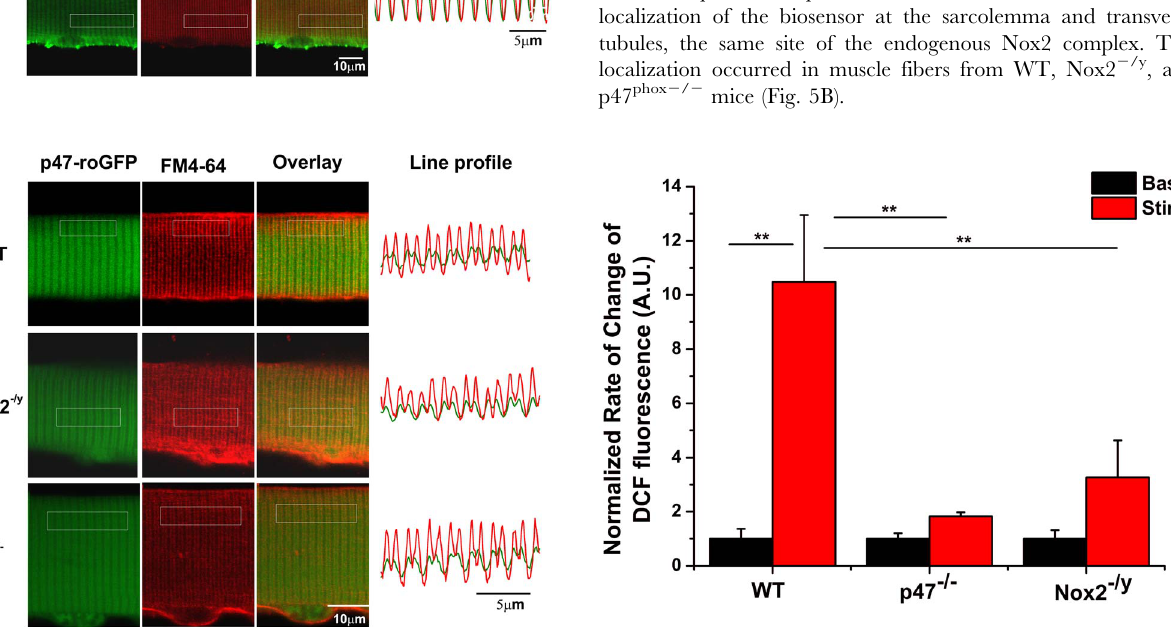
Figure 5. Localization of p47-roGFP in skeletal muscle. (A) Immunostaining of enzymatically dissociated single FDB myofibers for endogenous p47 phox and the ryanodine receptor shows that p47 phox co-localizes with the ryanodine receptor at the triad. (B) Fluorescent live cell image of an FDB electroporated with p47-roGFP and counter stained with the membrane and t-tubule dye FM4-64 H shows that p47- roGFP is localized at the t-tubule. The line plots represent the longitudinal spatial profile of fluorescence averaged over the transverse direction within the boxed regions.